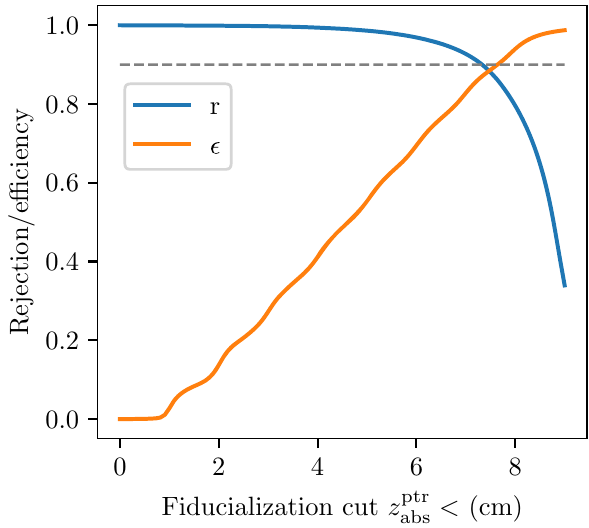
Fig. 12 Cathode track rejection rate r and signal efficiency (cid:8) versus fiducialization cut on z ptr on simulated tracks. For the purposes of abs this demonstration, we consider tracks with z truth = 9 cm to be “back- ground” and all other tracks to be “signal”. The dashed gray line indi- cates a rejection rate or efficiency of 0 .